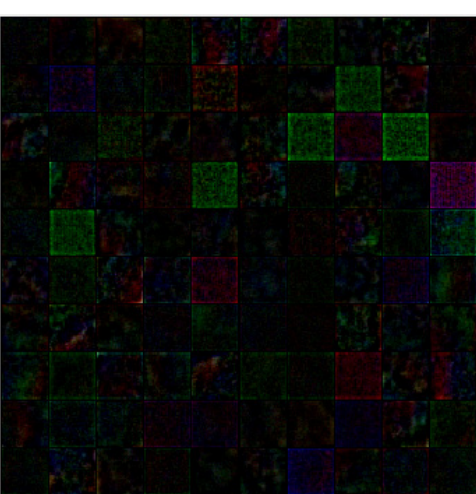
Figure 4. Representation of a random selection of 100 sub-images associated to the hidden layer of the ANN obtained in the second method. Each 30 × 30 patch corresponds to the weights of a hidden neuron represented in RGB values.